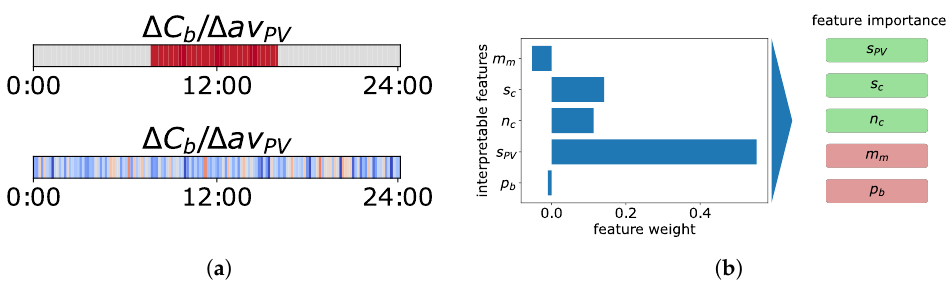
Figure 4. Comparison of sensitivity analysis and the proposed methodology for explaining the cost-optimal battery capacity C b at the POI cheap battery . ( a ): Sensitivity of C b towards changes in solar radiation availability av PV . Red values indicate a positive sensitivity, and blue values indicate a negative sensitivity. Top : deterministic cloud mapping and constant demand. Bottom : cloud mapping with random cloud sizes s c , random cloud distribution, and a standardized load profile. ( b ): Weights of the fitted linear model. Green implies positive influence, and red implies negative influence. The features are ordered by absolute weight magnitude on the